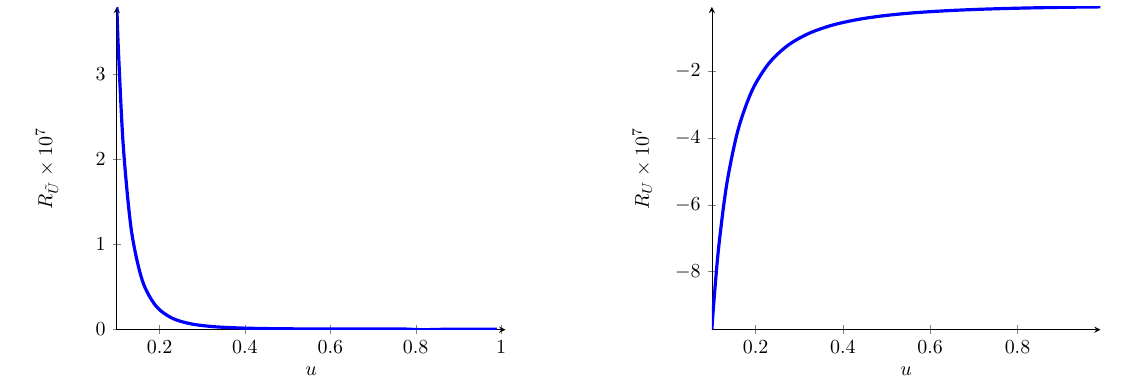
Figure 1 . Relative error between the analytic solution and the numerical solution R R U (right) as de(cid:12)ned in (3.45), obtained by calculating on a Gauss-Lobatto grid on the interval [ l; k ], with the choice d 1 = 1, d 2 = 0, l = 0 : 1 and k = 0 :